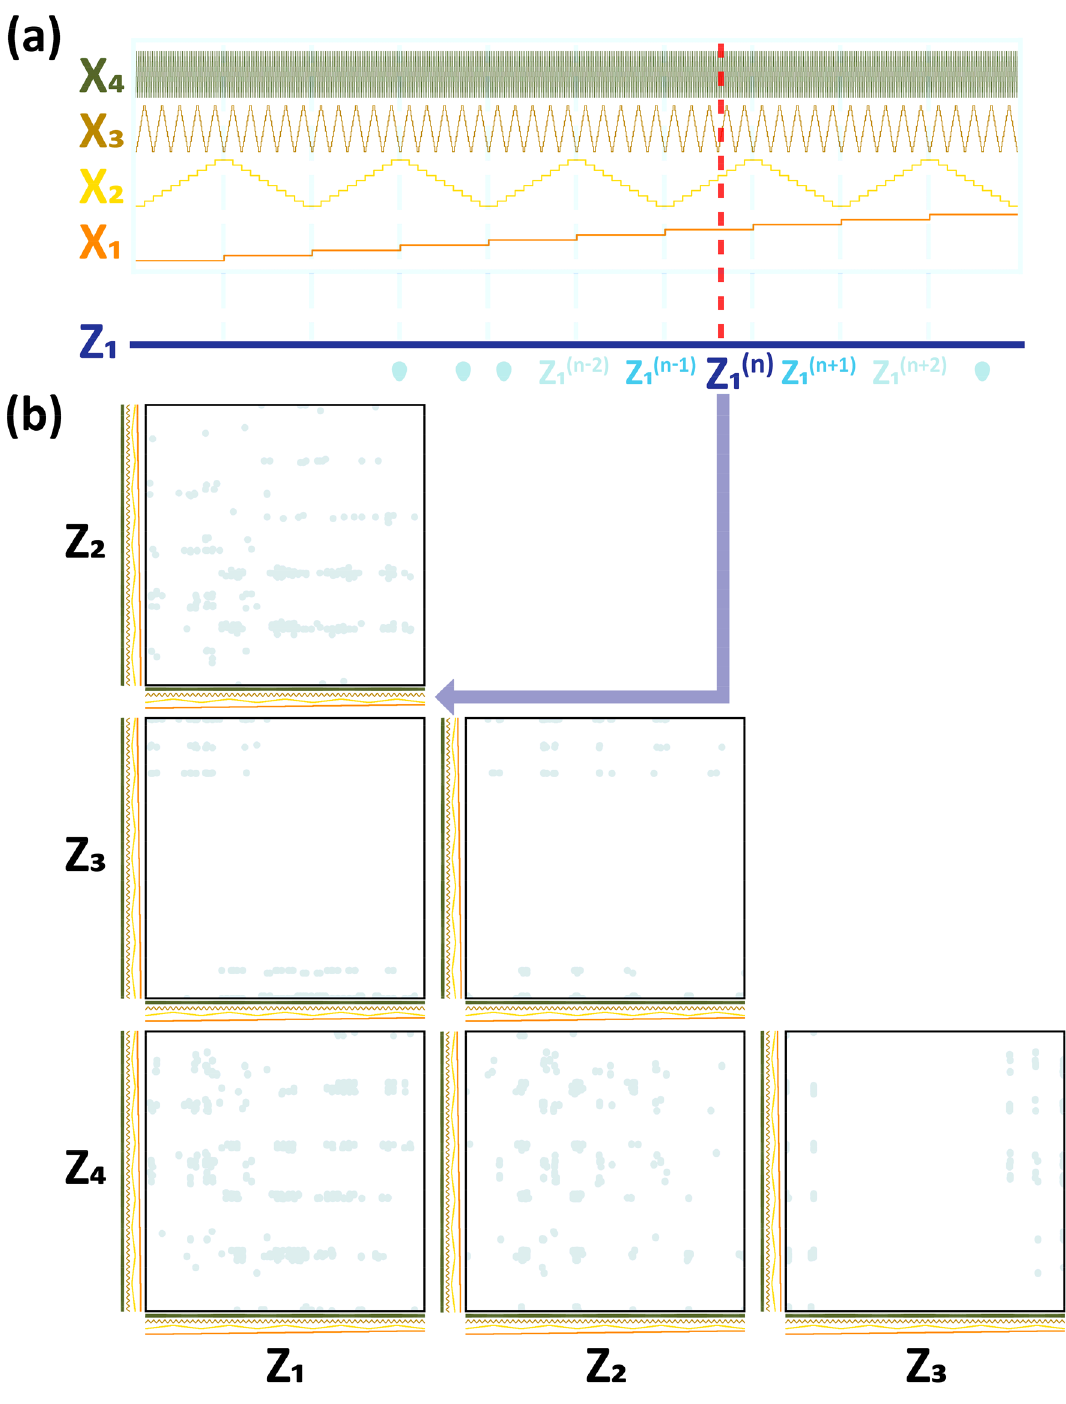
Figure 3. ( a ) HRS operation principle; four 10-level-descretized input features (x 1 –x 4 ) with four different periodicities, 2L for x 1 , 1/5L for x 2 , 1/50L for x 3 , and 1/500L for x 4 (L is the full width of the HSR plot). z 1 is a new HRS-merged input feature representing x 1 –x 4 . ( b ) the TMCP steel dataset distribution plotted on the HRS representation space. Six pair-wise 2-D scatter plots consisting of z 1 –z 4 , visualize the data distribution in much simpler manner. ( c ) alternative x i -z j feature mapping and (d) the corresponding15 pair-wise 2-D HRS scatter plots consisting of z 1 –z 6